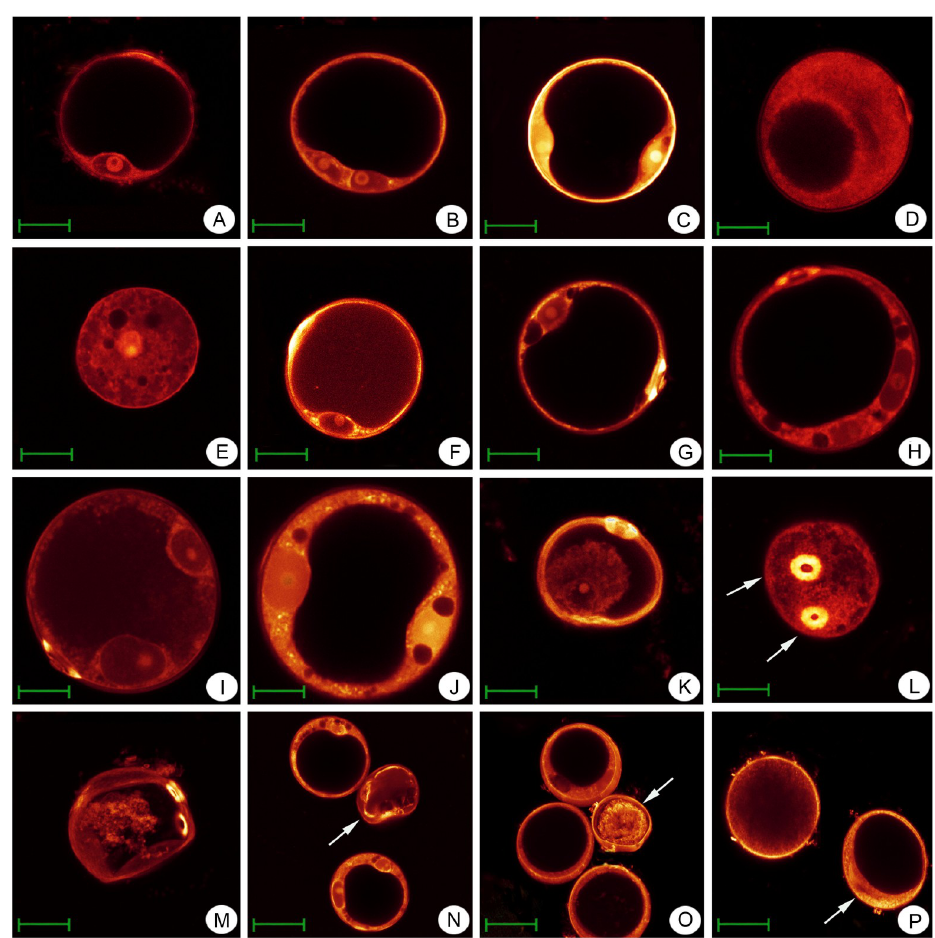
Fig 2. Microgametogenesis of Taichung65-4x and its corresponding diploid rice. (A-D) Microgametogenesis of Taichung65-2x. (A) Late microspore stage. (B) Early bicellular pollen stage. (C) Late bicellular pollen stage. (D) Mature pollen stage. (E-P) Microgametogenesis of Taichung65-4x. (E) Middle microspore stage, vacuolization. (F) Late microspore stage. (G) Late microspore stage. (H) Early bicellular pollen stage. (I) Middle bicellular pollen stage. (J) Late bicellular pollen stage. (K) Middle microspore stage, cell shrinkage. (L) Late bicellular pollen stage, multiple apertures. (M) Late bicellular pollen stage, cell shrinkage and multiple apertures. (N) Late bicellular pollen stage, arrow indicate the cell shrinkage. (O) Middle bicellular pollen stage, arrow indicate the cell shrinkage. (P) Mature pollen stage, arrow indicate the asynchronous pollens. Bars = 40 μ m.